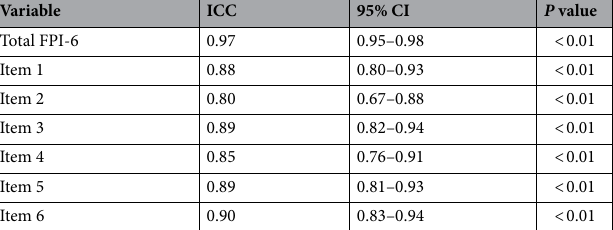
Table 2. Inter-rater reliability of the FPI-6. Total FPI-6, Foot total score of FPI-6; ICC, intraclass correlation coefficient; Item 1, talar head palpation; Item 2, curves above and below the lateral malleolus; Item 3, a bulge in the region of the talonavicular join; Item 4, eversion and inversion of the calcaneus; Item 5, congruence of the medial longitudinal arch; Item 6, adduction and abduction of the forefoot in relation to the rear